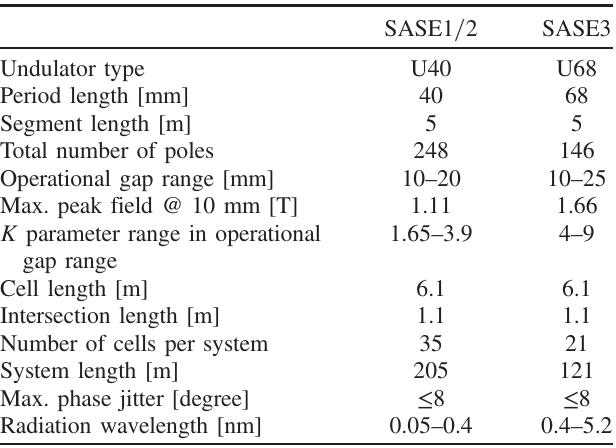
TABLE I. Specifications for the undulator segments of the EXFEL.